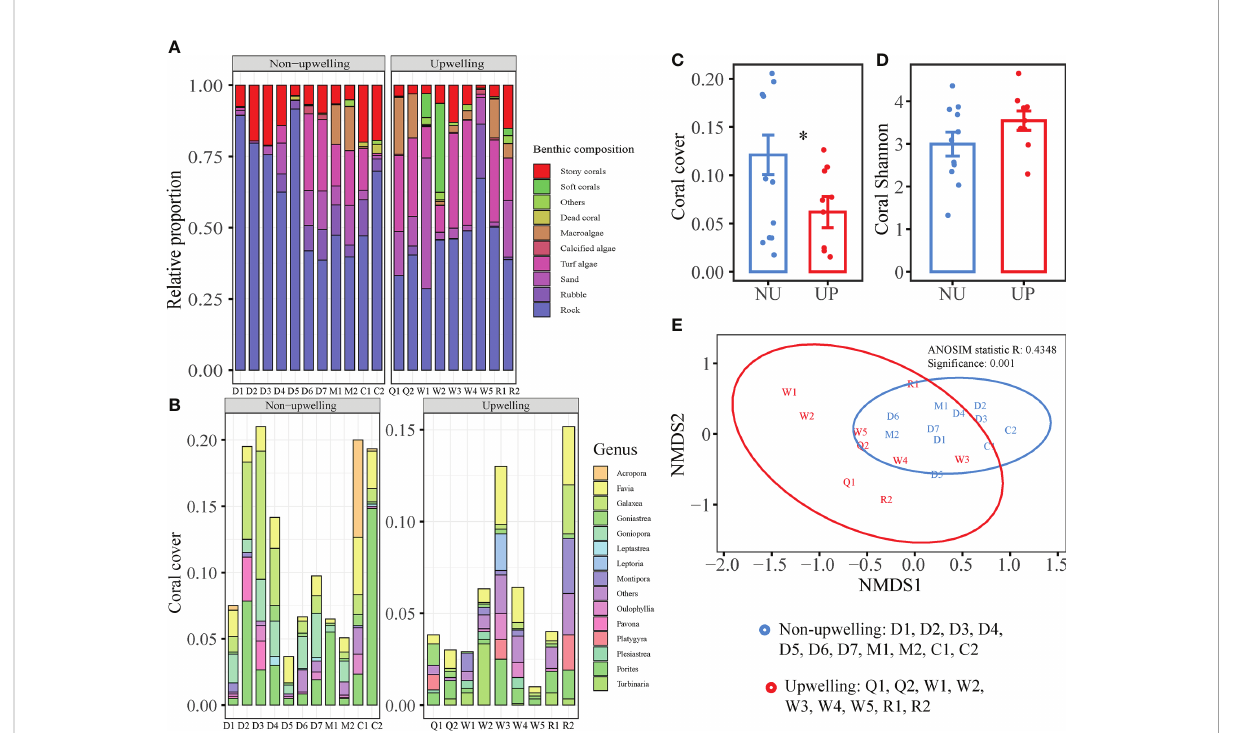
FIGURE 4 Comparison of benthic composition, coral composition, coral coverage, coral diversity, and coral community of the QDU and non-upwelling zone: (A) Percentage cover of coral reef composition; (B) Percentage composition of hard coral at genus level; (C) Total coral coverage;